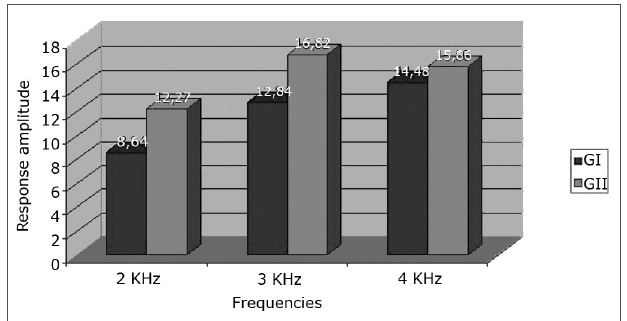
Figure 2. Response amplitude at 2K, 3K and 4KHz frequency ranges in transient otoacoustic emissions testing in the left ear in both study groups.